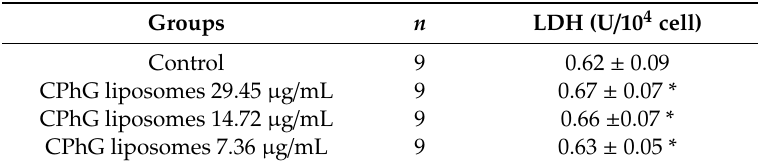
Table 3. Influence of CPhGs liposomes on LDH secretion in HSCs.